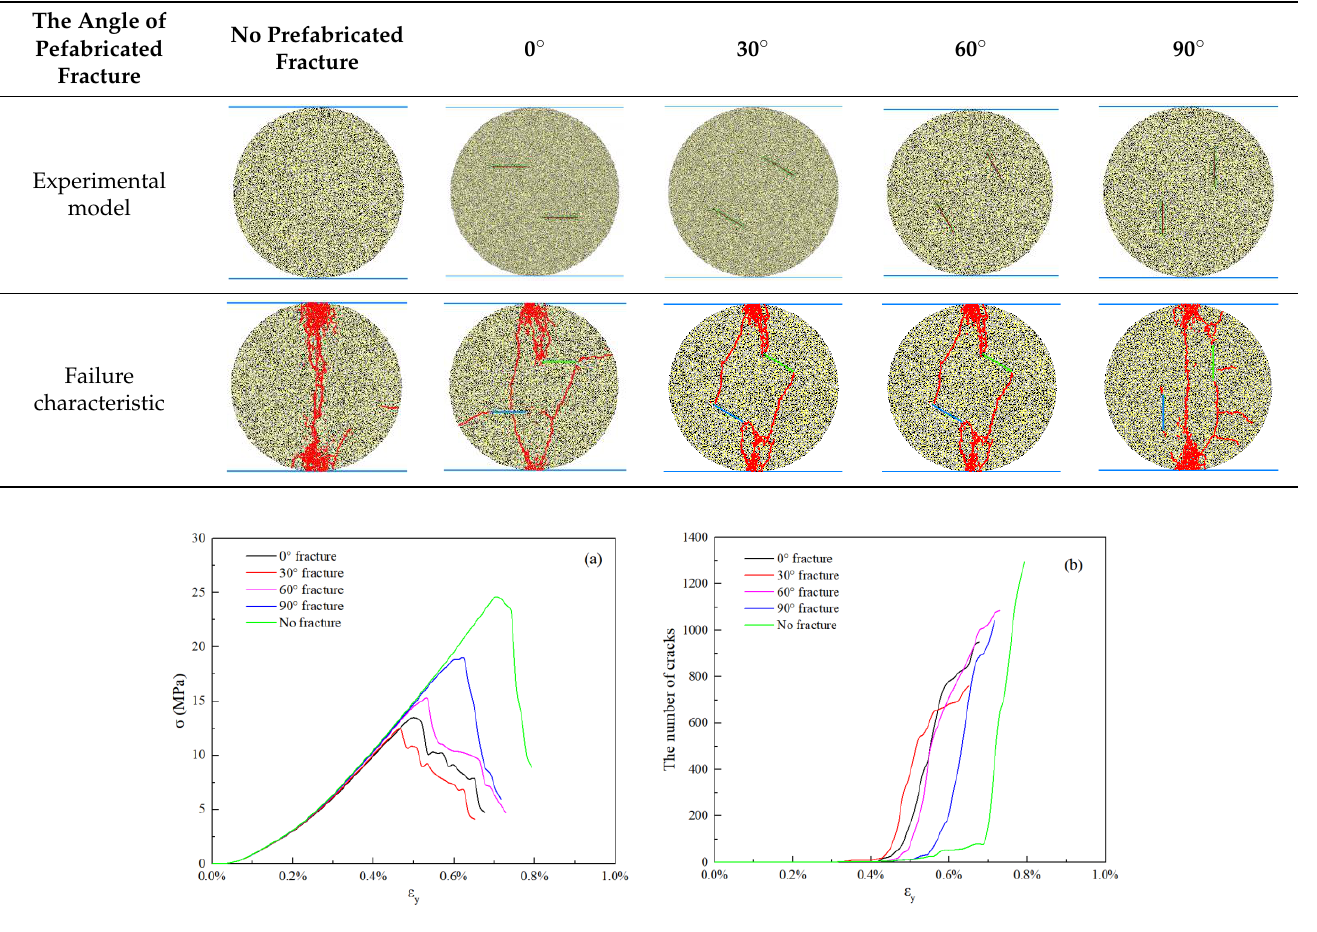
Figure 4. ( a ) The stress-strain curves and ( b ) the number of cracks of prefabricated fracture samples with different angles under Brazilian splitting.